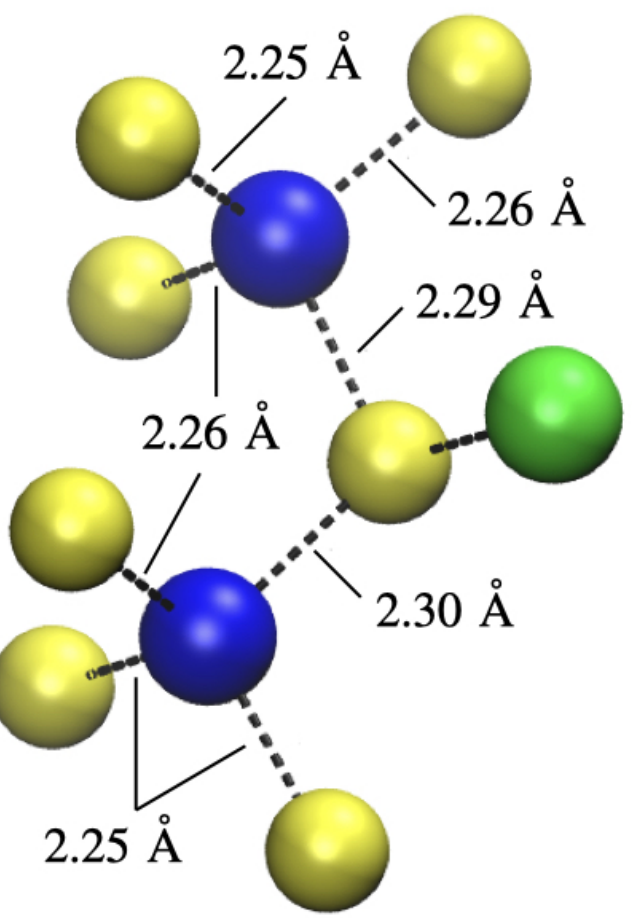
Figure A1. Al-S bond lengths for Al close to [ Fe Cu ] 2 + antisite defect (only half of the nearest neighbour Al sites are shown for purposes of clarity).